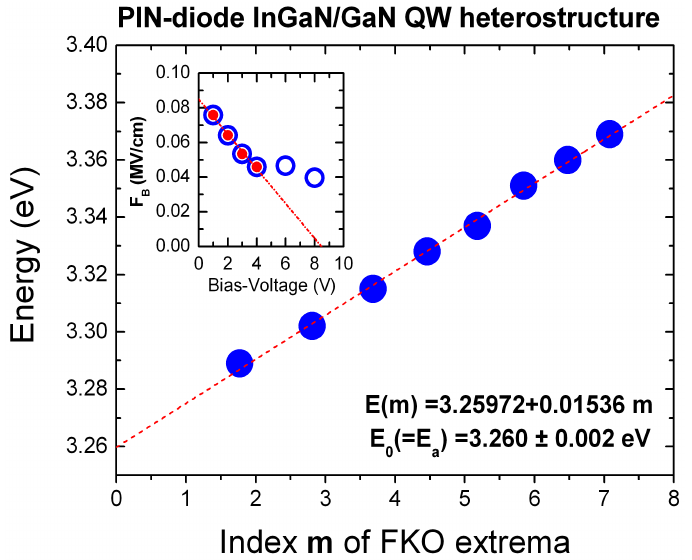
Figure 5. Linear fitting of the Franz–Keldysh oscillation (FKO) extrema of the ER spectrum of the In 0.055 Ga 0.945 N / GaN DHS of Figure 4b (inset: electric field in the barrier and depletion region interface in dependence of bias-voltage).